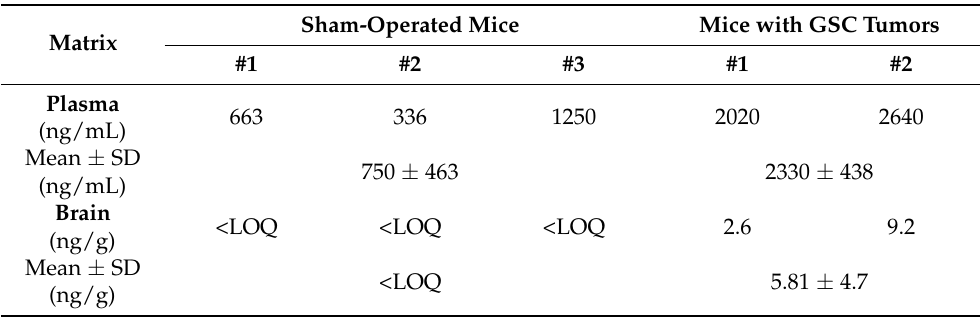
Table 8. NAZ concentrations in the brain tissue and plasma of grafted and sham-operated mice treated i.p. at a dose of 15 mg/kg (3 times/week for 3 weeks).